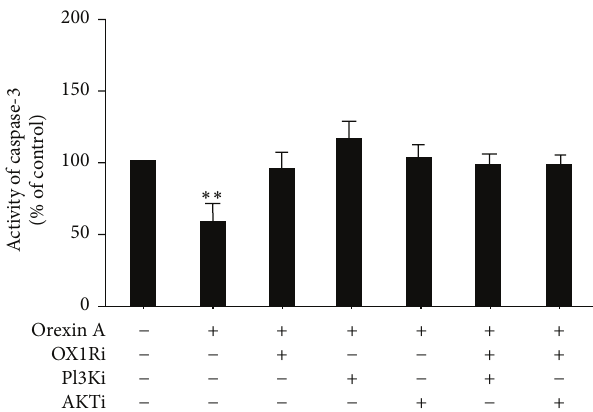
Figure 4: OXA increases INS-1 cell proliferation via the AKT signaling pathway. INS-1 cells were treated with OXA (10 −6 M) for 20 min in the presence of PF-04691502 (AKTi) (10 −6 M), wortmannin (PI3Ki) (10 −8 M), SB334867 (OX1Ri) (10 −6 M), or the combination of these antagonists. The phosphorylation of AKT ( 𝑝 - AKT) (corresponds to 60 kDa) was normalized against the total protein ( 𝑡 -AKT) activation. The 𝑡 -AKT protein expression was used as an internal control for equal protein loading. Protein activation was measured by western blot analysis. Data are presented as mean ± SEM based on triplicate determinations from a representative experiment. Asterisks indicate significant differences compared to control samples ( ∗ 𝑃 < 0.05) .